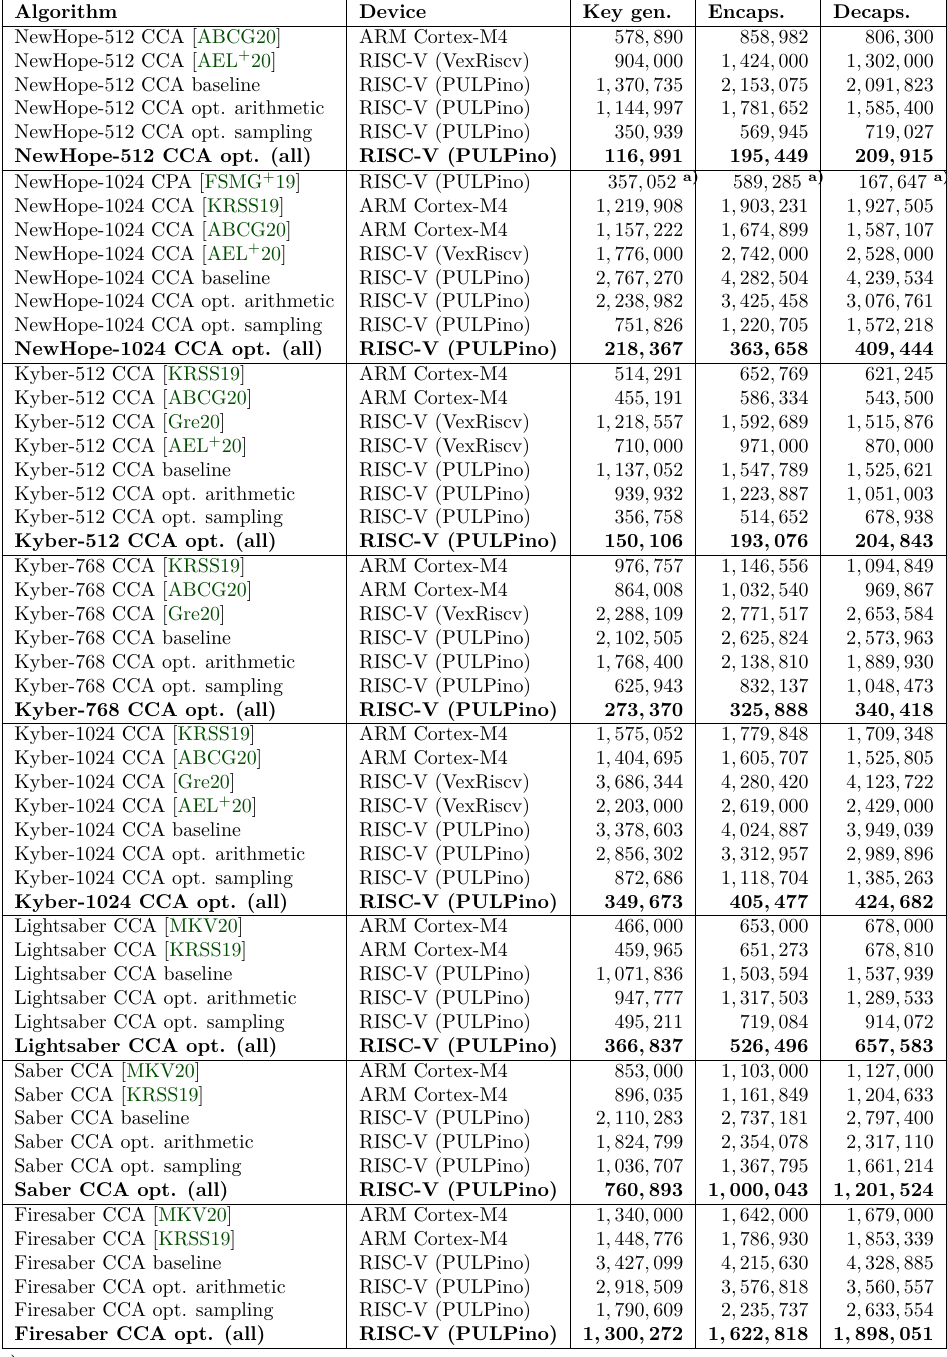
Table 5: Cycle count (O3, riscv32-unknown-elf-gcc 7.1.1 20170509,